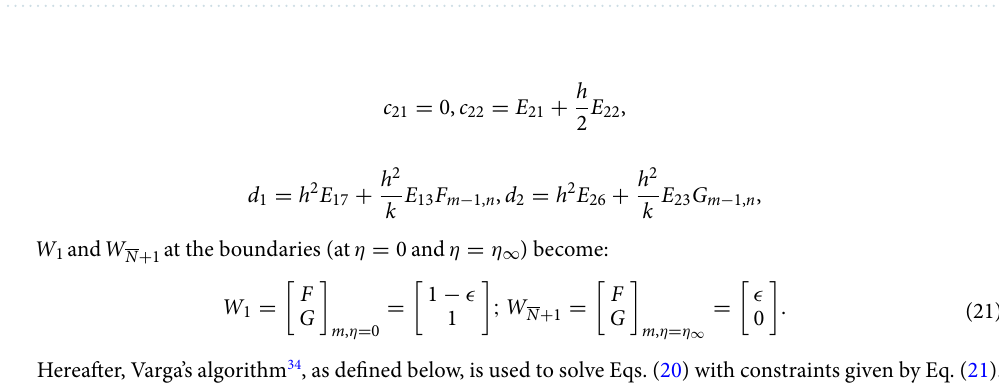
Table 4. Comparison of current results with available works 54–56 in literature for the case of steady-state with